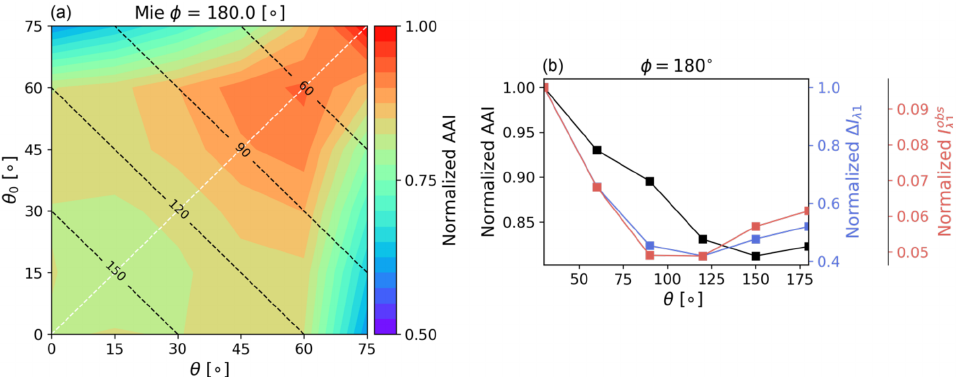
Figure 6. AAI sensitivity to θ and θ 0 at ϕ = 180 ◦ . The black dashed contour in panel (a) indicates (cid:50) = 60, 90, 120, 150 ◦ . The white dashed line in panel (a) indicates the cross section along viewing angles, with its corresponding normalized AAI, (cid:49)I λ in panel (b)